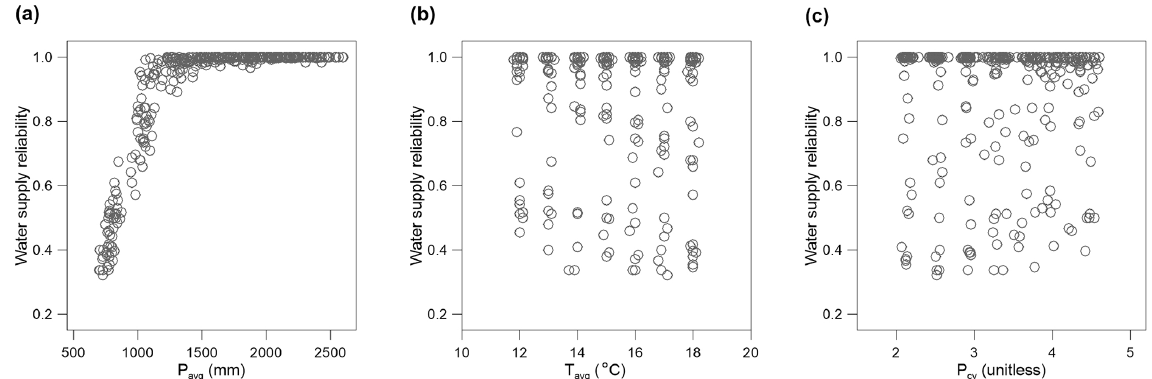
Figure 2. Scatter plots between the water supply reliability at the sub-basin 3001 and changes in (a) P avg , (b) T avg , and (c) P cv collected from the stress tests driven by the 539 sets of stochastically generated stress-imposed weather